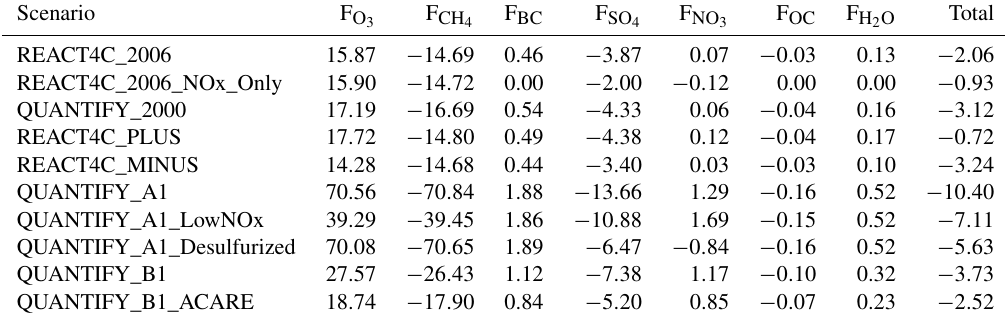
Table 5. Radiative forcings (RFs) of ozone, methane, black carbon (BC), sulfates, nitrates, organic carbon (OC) and stratospheric water vapour calculated for the different simulations (mWm − 2 ). The RF of methane is the sum of 4 terms as depicted in Table 5.